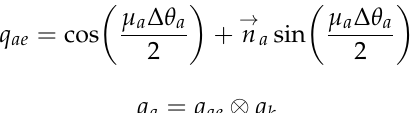
in static and dynamic tests without overshooting too much. The determination of the parameter µ a in various working conditions will be given in the experiment section.